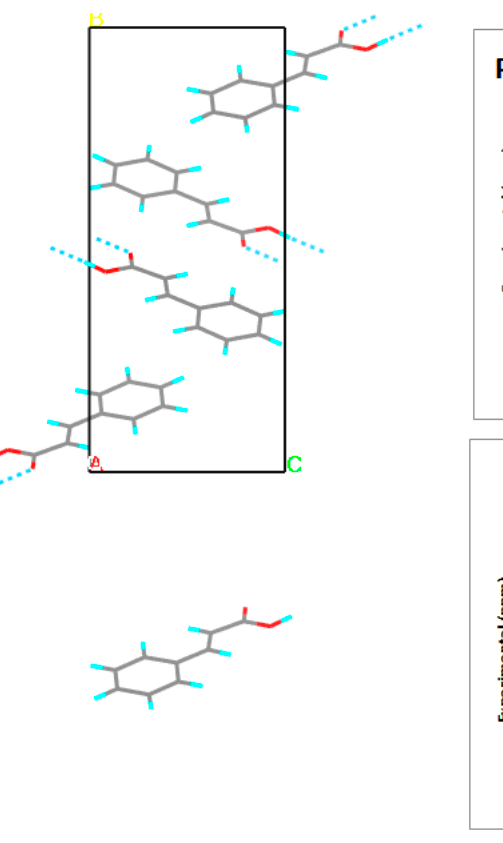
Figure 6. Results of Nuclear Magnetic Resonance (NMR) calculations for trans-cinnamic acid. On top using periodic DFT (GIPAW CASTEP), below using single molecule (GIAO Gaussian). By using periodic DFT calculations not only higher coefficient of determination (R 2 ) but also slope closer to 1 were achieved. Source: author’s archive, more details [187].